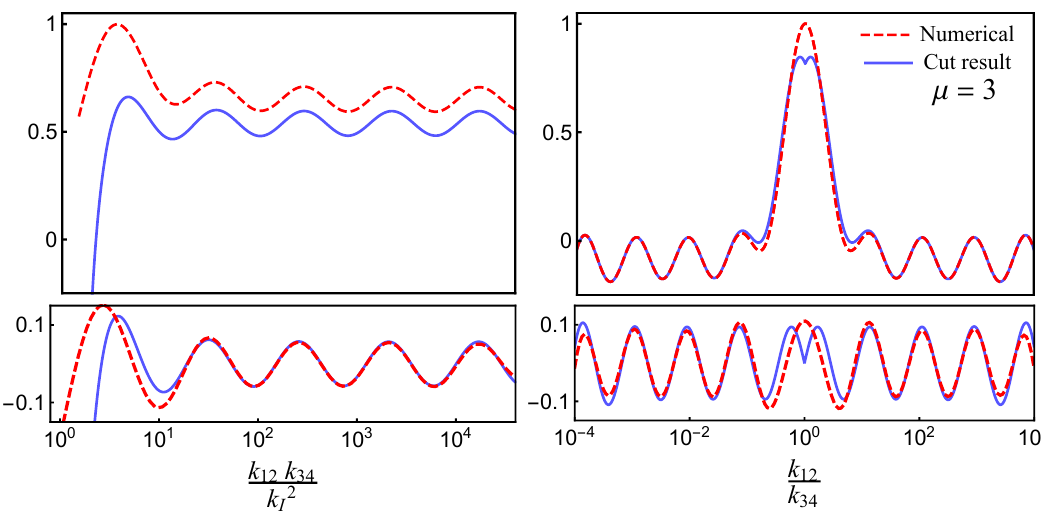
Figure 7 . The comparison between the 4-point functions obtained from the cutting rule (blue lines) and numerical integration (red dashed lines). Left panel: non-local type CC signals, where we have fixed k 12 /k 34 = 1 , and multiplied a factor panel: local type CC signals, where we have fixed k 12 k 34 /k 2 panels are normalized by their maxima. In the lower panels, we compare the CC signals filtered from the numerical result and those directly obtained via the cut. We have adopted a high-pass filter with Hamming